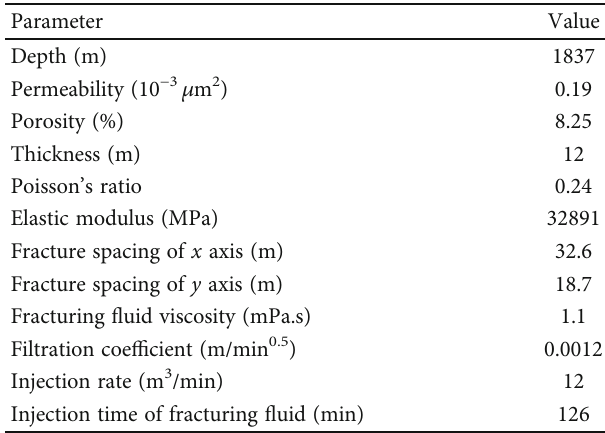
Figure 6: Flow chart of the inverse algorithm for numerical solution. Table 2: Reservoir and construction